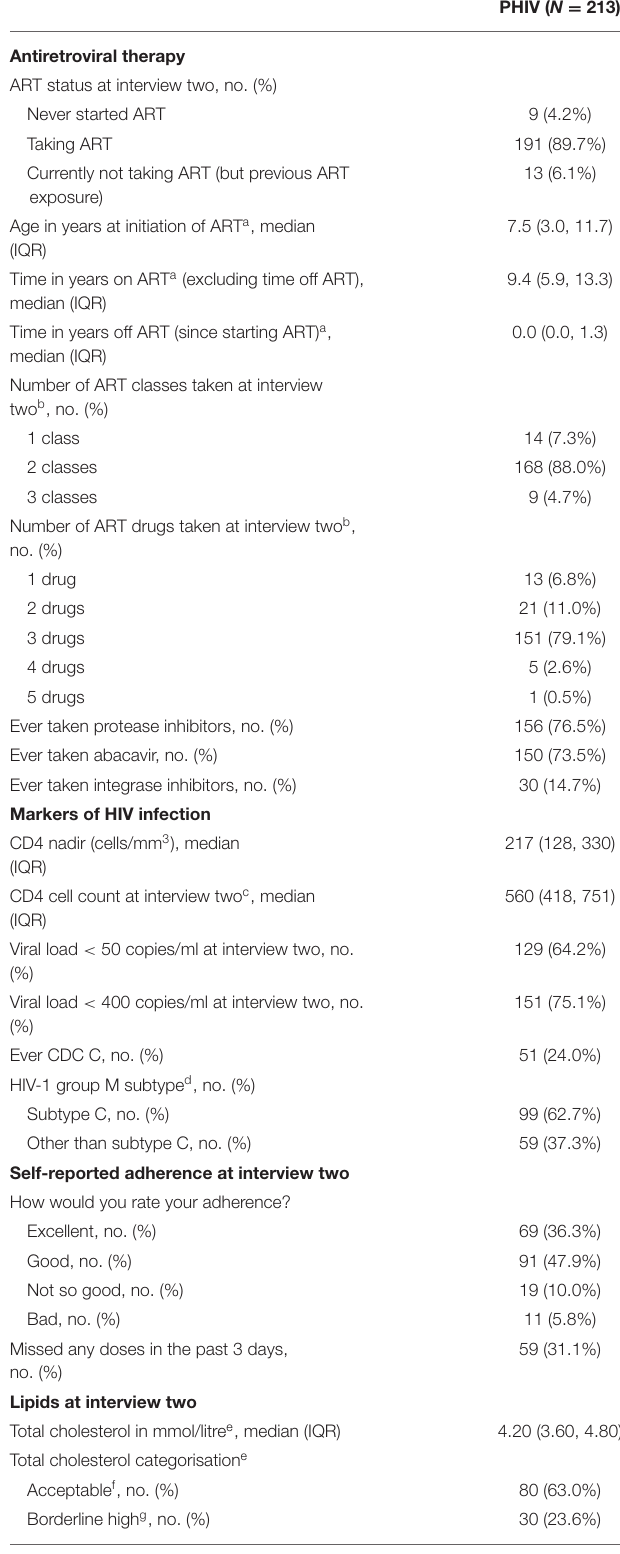
TABLE 2 | HIV clinical markers and lipids levels of PHIV